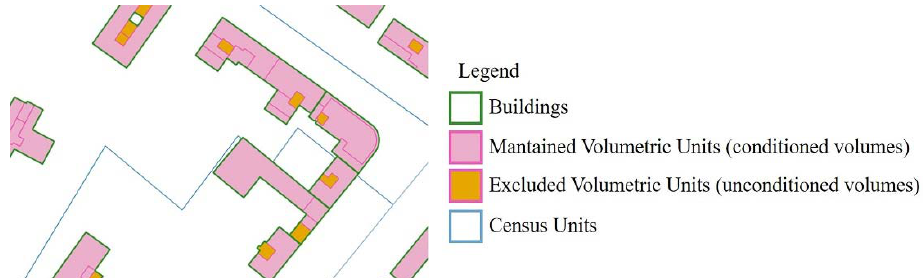
Figure 6. Exclusion of unconditioned volumes.